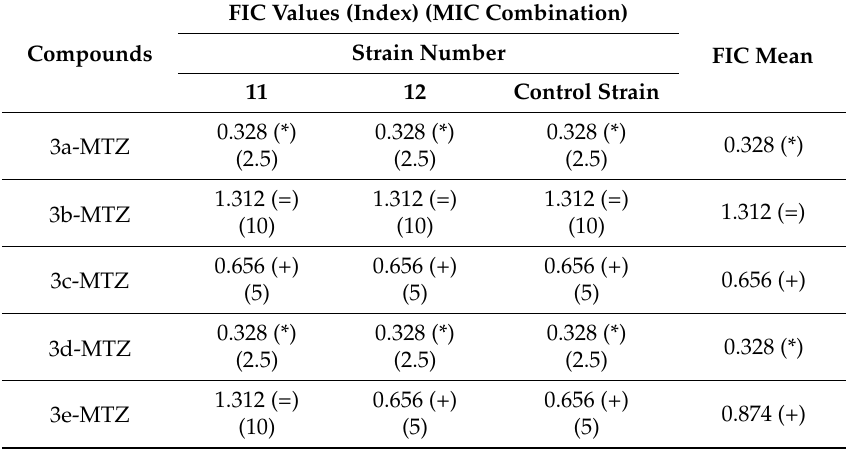
Table 3. Fractional inhibitory concentration (FIC) values of tested compounds in combination with metronidazole against clinical strains of H. pylori ( 11 , 12 ) and control strain by standard checkerboard titration method with two-fold serial agar